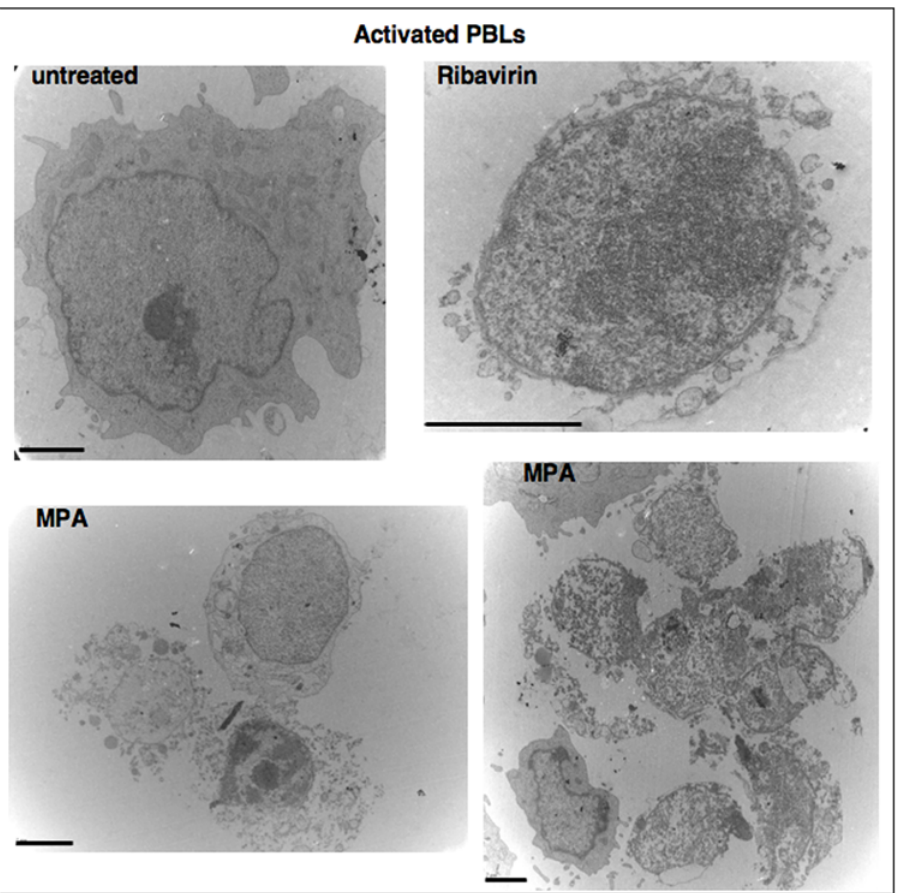
Figure 1. IMPDH inhibition leads to a necrotic morphology. Electron micrographs of activated PBLs. Cells were incubated with MPA (3 m g/mL) or with ribavirin (100 m g/ml) for 44 hours (Bars=2 m m).